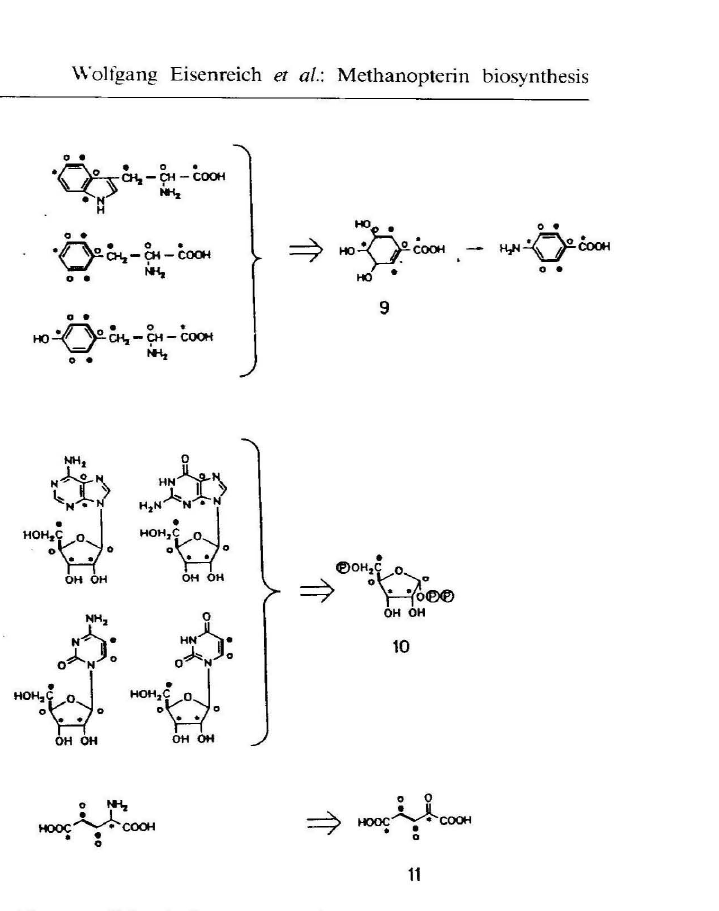
Figure 5. l3C-Labeling pattern of aromatic amino acids, nuc leosides, and glutamate from M thennoautotrophicum. Carbon atoms labeled from [1- 13 C]acetate (0), [2- iJ C]acetate (e). [ 1- 13C]pyruvate (*). and L-[methyl- 13 C]methionine (6 ) are indi cated. The joint transfer of two carbon atoms from [1,2- 13 CJ acetate as shown by l3C_13C coupling is indicated by bold lines. The symbol =} indicates reconstructed precursors in ana logy to the retrosynthesis concept in organic